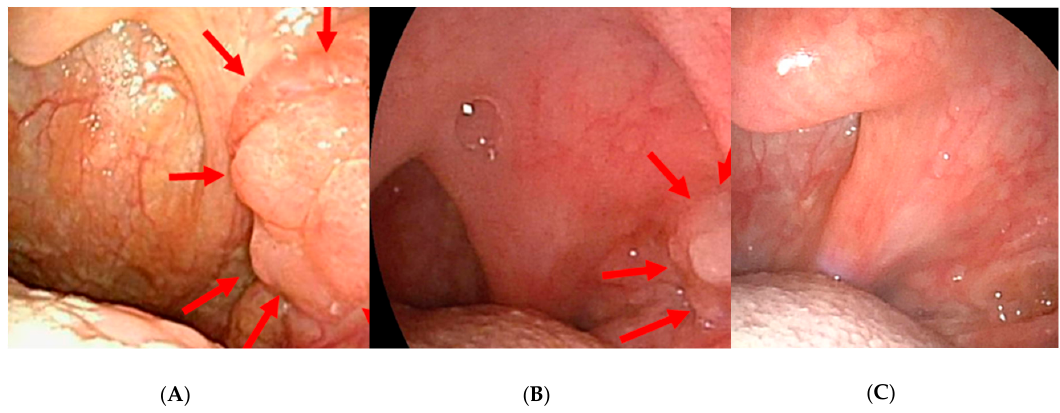
Figure 1. Gross findings of the primary lesion before and after neoadjuvant chemotherapy. ( A ) Left middle pharyngeal lateral wall (palatine tonsil) before chemotherapy showing a neoplastic lesion with papillary growth centered at the upper to middle pole (arrows). ( B ) Left oropharyngeal lateral wall after the first chemotherapy session showing a marked reduction in tumor size. ( C ) Left nasopharyngeal lateral wall after the second chemotherapy session showing disappearance of the tumor.